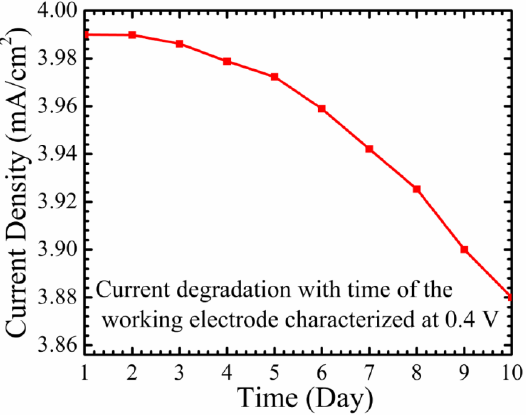
Figure 10. The degradation and producibility of the current density for the fabricated working electrode, which was characterized at 0.4 V.